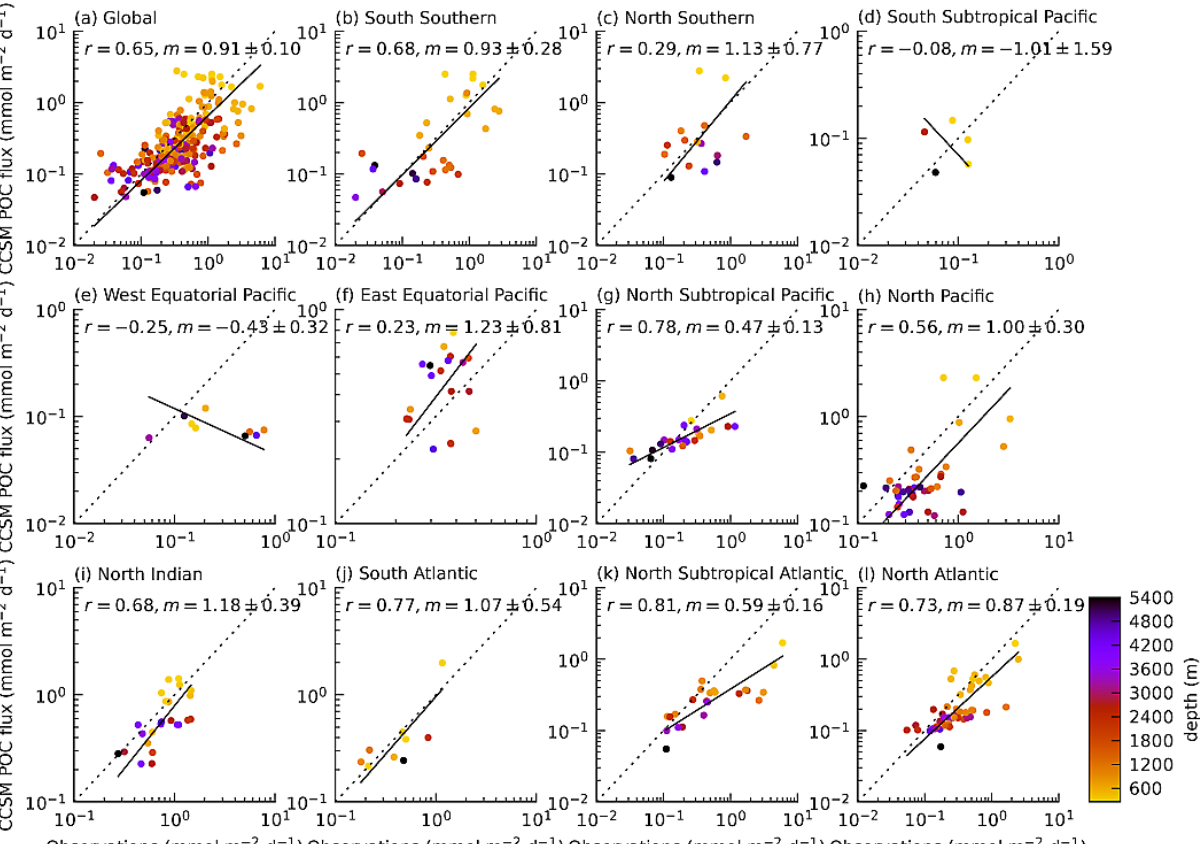
Fig. 2. Annual mean POC flux from CCSM–BEC model at sediment trap locations and depths plotted against observations from the Lutz data set for the whole globe (all points combined) and each domain region (Fig. 1). Sediment trap data is absent in the southern Indian Ocean, so that region is not shown. Solid black lines show type II linear regression and dotted black lines show the 1 : 1 slope. The correlation coefficient ( r ) and regression slope ( m ) for the log 10 -transformed data are shown in each panel. Color scale indicates depth of sediment traps.